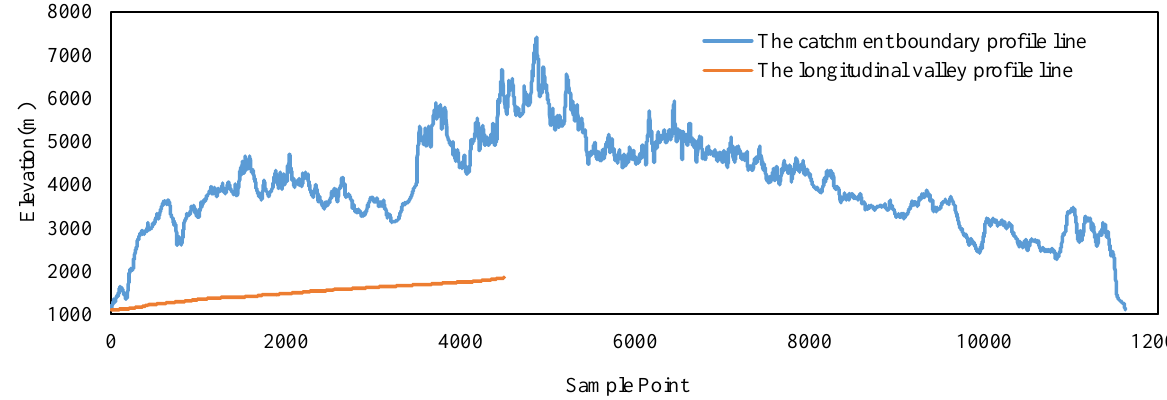
Figure 5. The catchment profile spectrums of four tributaries According to the elevation distribution histogram of catchment boundary profile lines are similar. The Yovonsu River has small boundary profile line, histogram of the Yovonsu River shows a amplitude, which is located in the wide valley with little low kurtosis. The Kizilsu River and the Muksu River have elevation fluctuations. The frequency of wave of the four basins obvious high kurtosis. The histograms all have an exclusive are similar, and the mean value is about 0.0552. From the aspect rectangular band, indicating that the elevation of the boundary of gully density, the four basins are basically in the stable stage. profile lines are concentrated in the ranges of 4,000-5,000m, With the side erosion of the river, channel becomes wider and 5,000-5,500m respectively, which reflects the top part of the terrain gradually becomes flatter so that the gully density are catchment boundary profiles remain stable relatively. Because small. the elevations of the two basins are concentrated, the profile lines keep monotonicity from the outlet to the first local surface peak. And the boundary elevation of the Obikhingon River is tally with the normal distribution basically, which results in the small kurtosis and skewness.